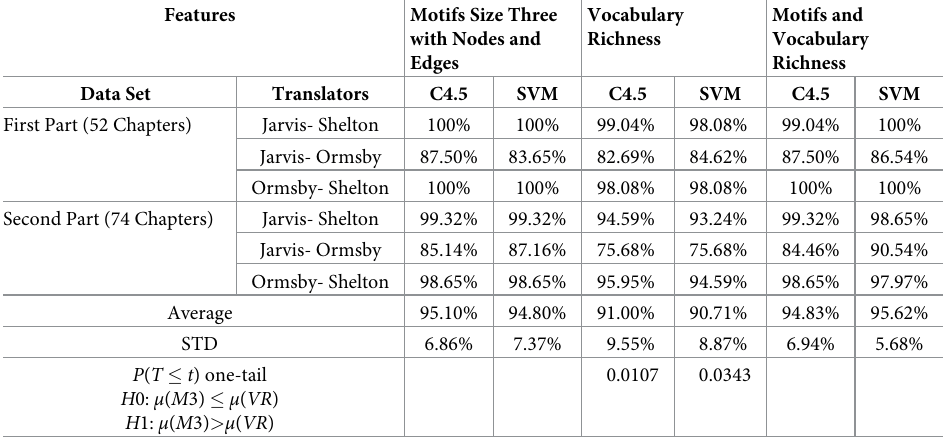
Table 12. Classification results for applying ranking to motifs of size three and vocabulary richness as translator stylometry features for the 2nd corpus.